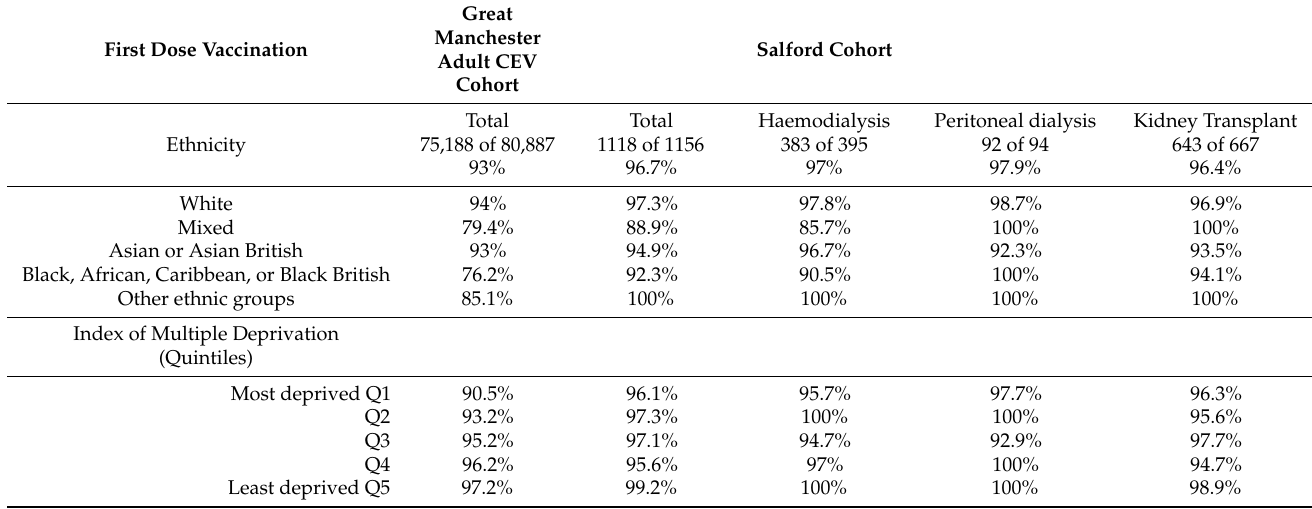
Table 2. Comparison of first dose vaccination uptake based on ethnicity and index of multiple deprivation between Salford cohort and Greater Manchester adult